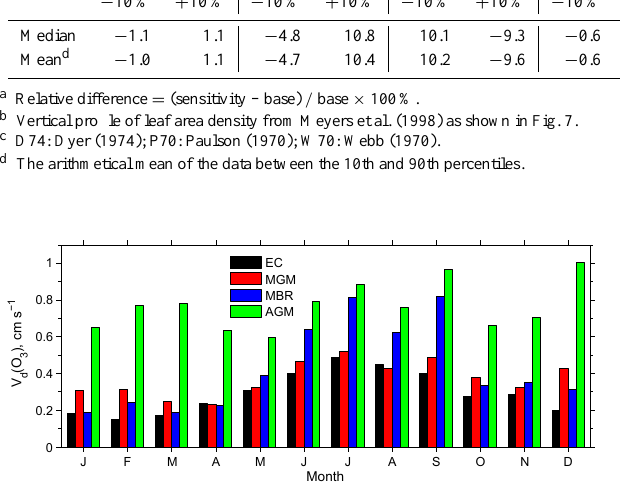
Figure 5. Monthly average of V d ( O 3 ) at Harvard Forest during 1993–2000 as measured by the eddy covariance (EC) and three gra- dient methods (MGM: the modified gradient method; MBR: the modified Bowen ratio method; AGM: the aerodynamic gradient method). Note that the average is the arithmetical mean of data be- tween 10th and 90th percentiles.